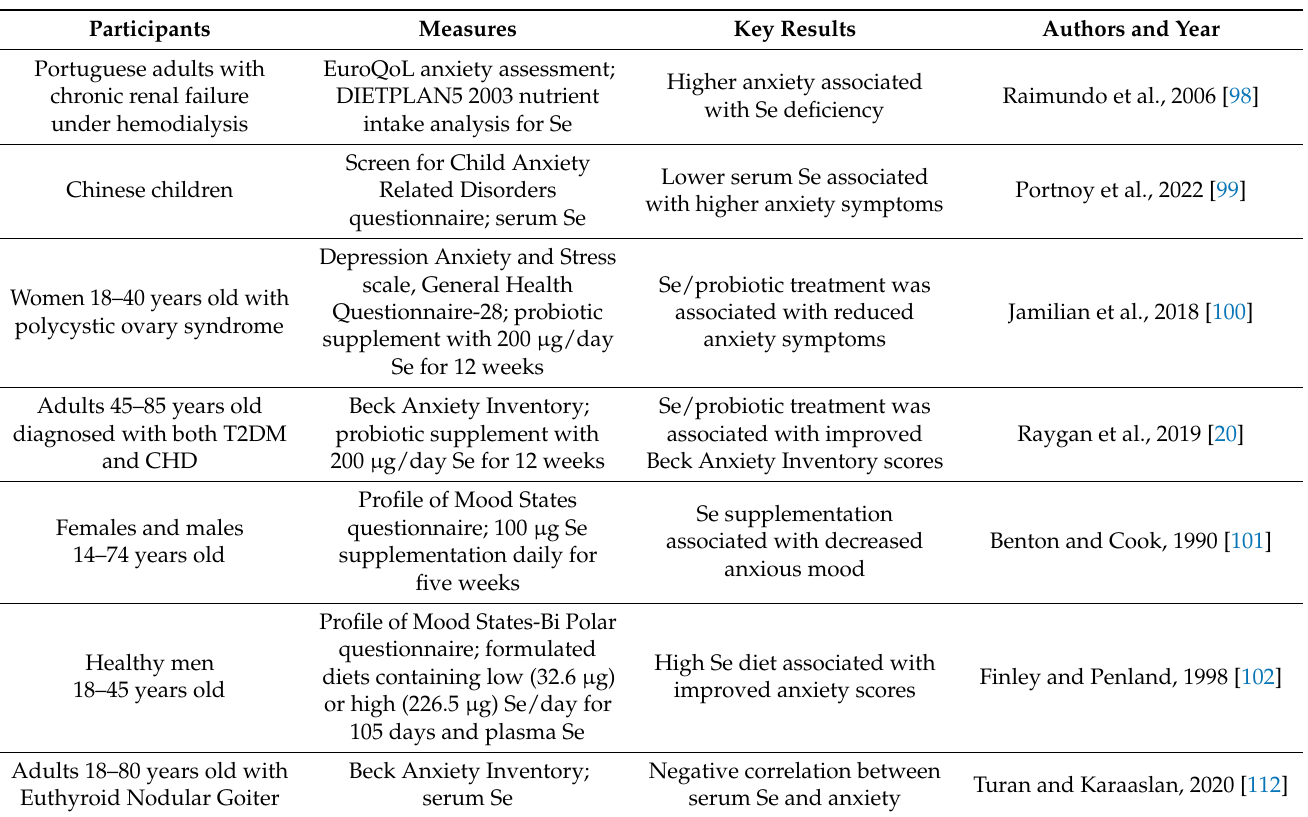
Table 4. Summary of clinical evidence for the relationship between selenium (Se) and